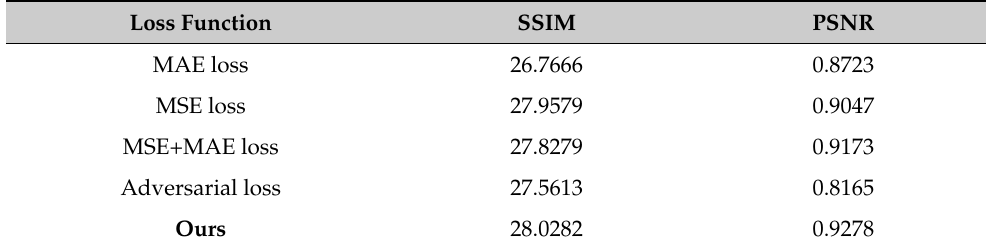
Table 2. Network performance comparison of different loss functions.